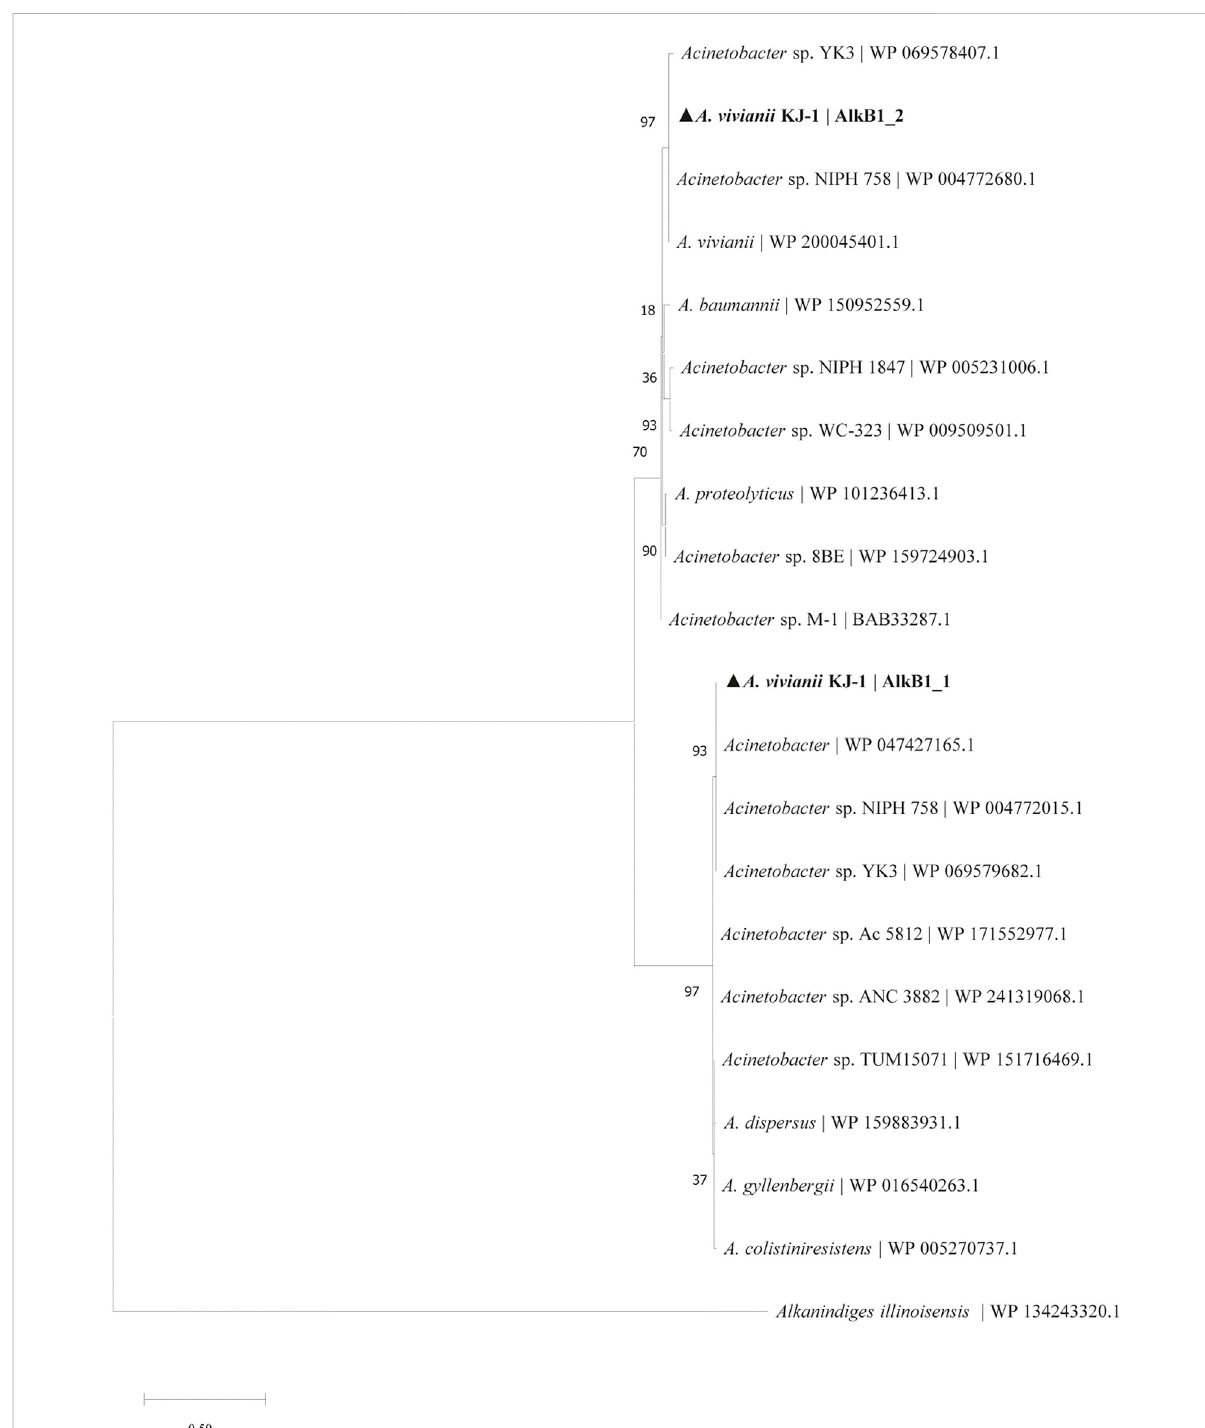
FIGURE 6 Phylogenetic relationship of Alkane monooxygenase of A. vivianii KJ-1 with other closely related species using maximum likelihood method. Theoutgroup usedwasAlkB proteinfrom Alkanindigesillinoisensis (WP 134243320.1).The bootstrap valuerepresents 1,000 replicates, andtree was built using Mega